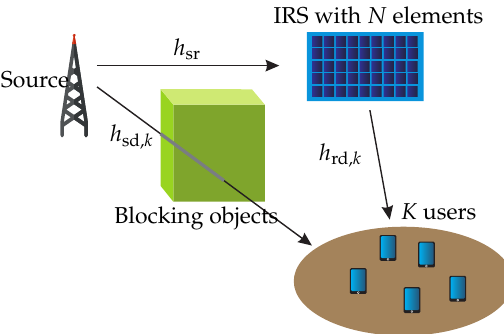
Figure 1. IRS-assisted multi-user communications.